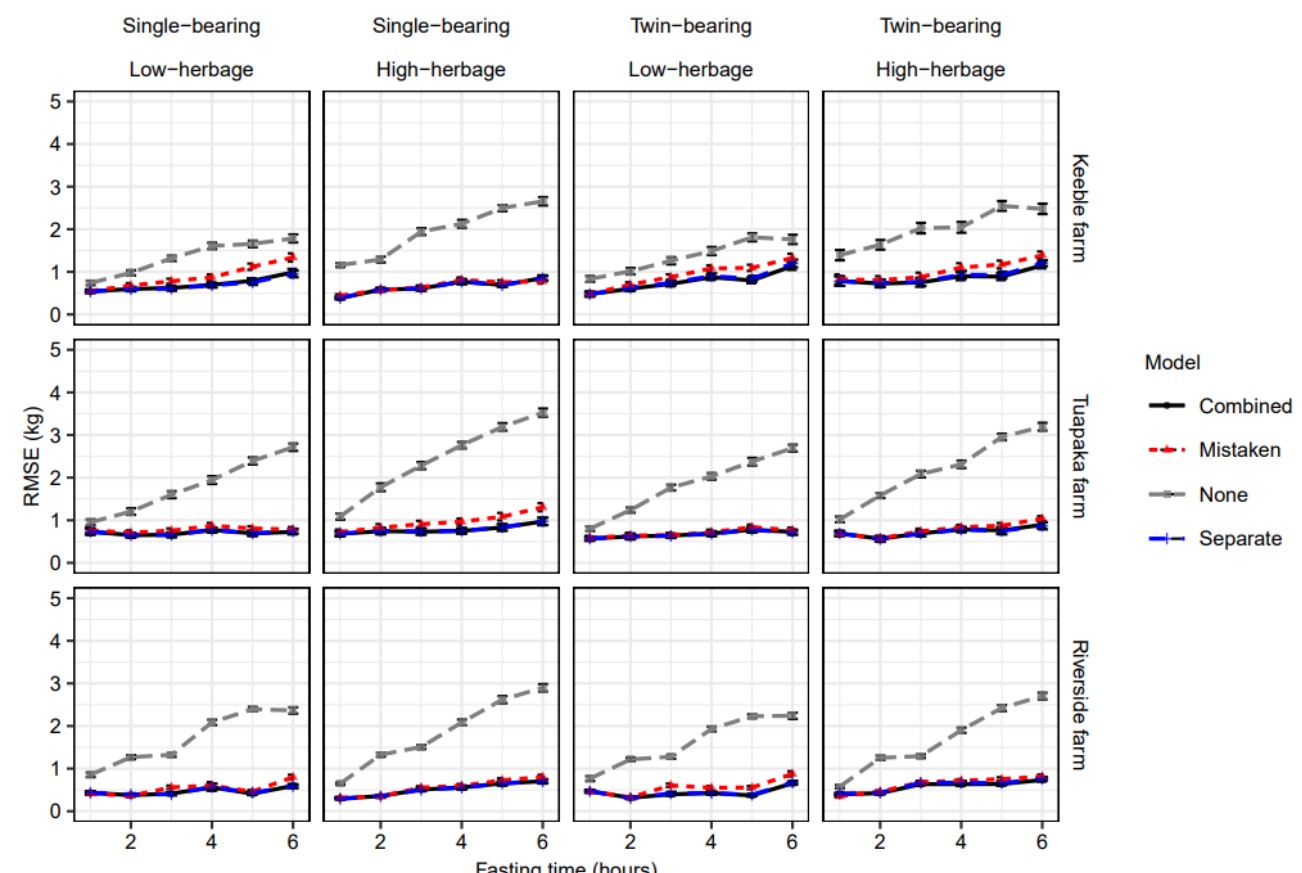
Figure 4. Change in root mean square error (RMSE) with the associated standard deviation for the prediction of without delay liveweight of P130 ewes over fasting time when different correction equations/models (Separate, combined, mistaken and none) for each target herbage (Low and High) and pregnancy-rank (single and twin) generated in stage one were applied on data collected in the winter season of 2020 by each farm (Keeble, Tuapaka and Riverside). Availability level (Low herbage target range: 900–1100 kg DM/ha, High: ≥ 1400). Correction equations: treatment combination; specific or separate: herbage, stage of pregnancy and pregnancy-rank; specific or combined: consolidated equations with similar effect; mistaken: any of the availability level specific equations wrongly applied to a different treatment combination.